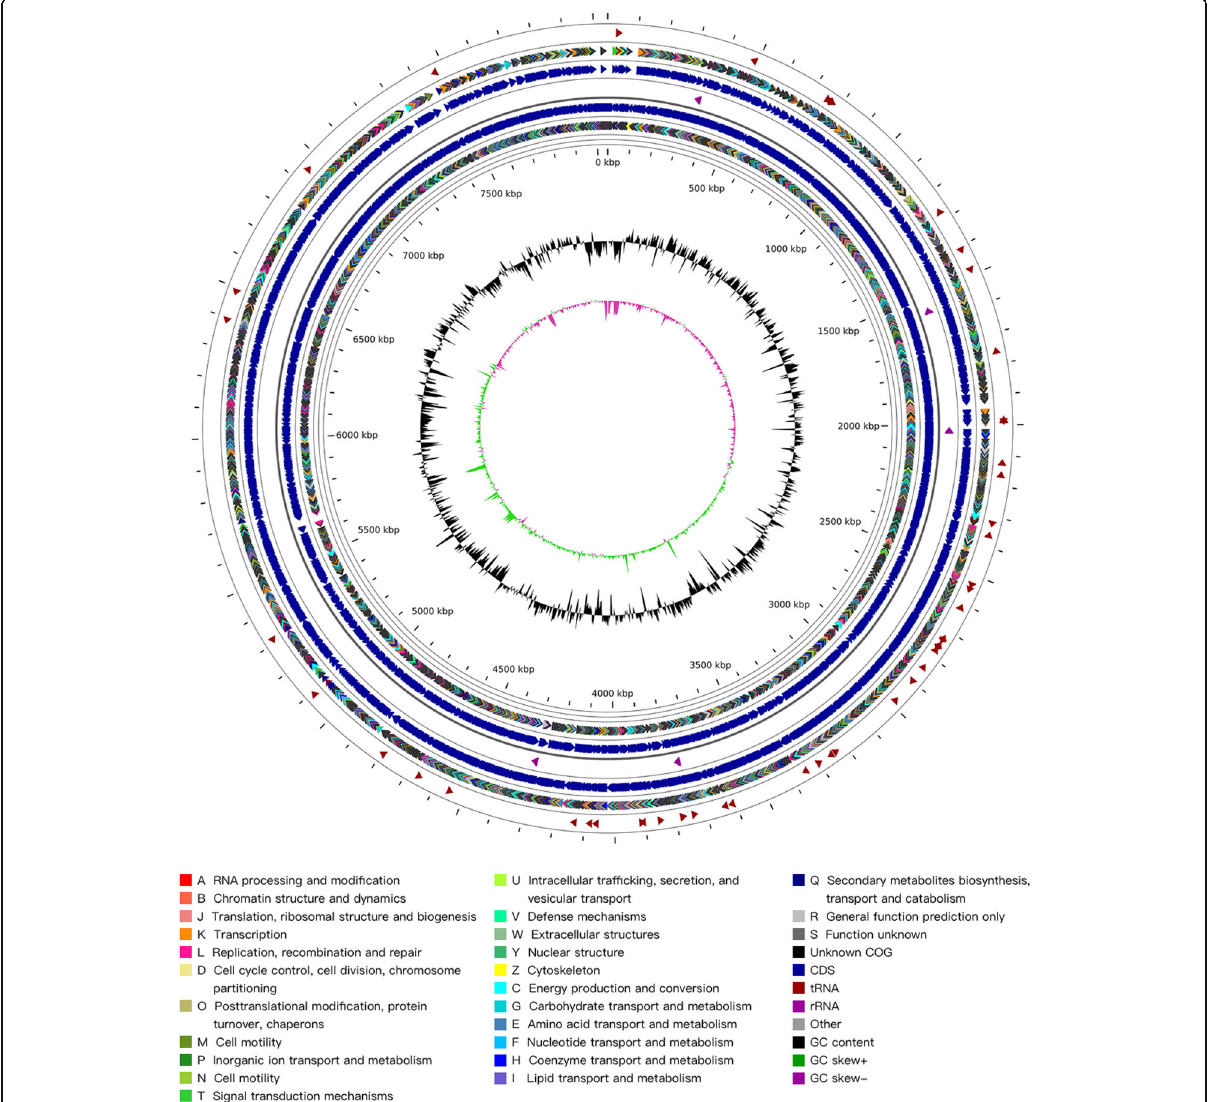
Fig. 2 Circular representation of strain ASAGF58 chromosome (from outside to inside): tRNA genes, Clusters of Orthologous Groups of proteins (COG) annotation on the forward strand, location of genes on the forward strand, rRNA genes, COG annotation on the reverse strand, location of genes on the reverse strand, GC content (taking the mean value as the baseline, the expression of the outward protrusion is higher than the mean value, and the expression of the inward protrusion is lower than the mean value), GC skew (the expression of purple means less than 0, and the expression of green means more than